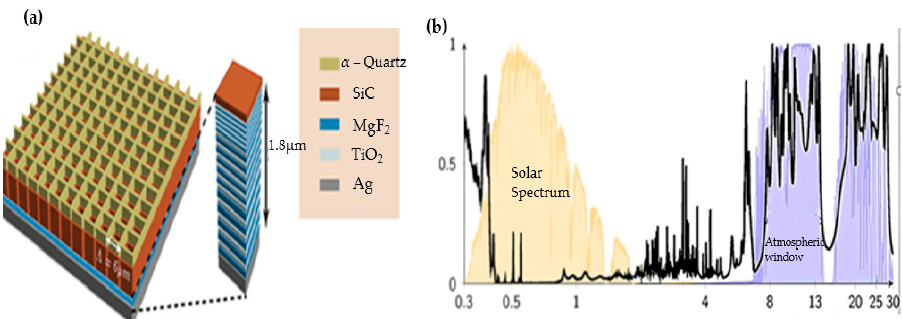
Figure 16. ( a ) DPRC design that consists of two thermally emitting photonic crystal layers ( b ) DPRC emissivity ε ( λ ,0) is shown in normal incidence (black), with the scaled AM1.5 solar spectrum (yellow) and atmospheric window transmittance (blue) [45].